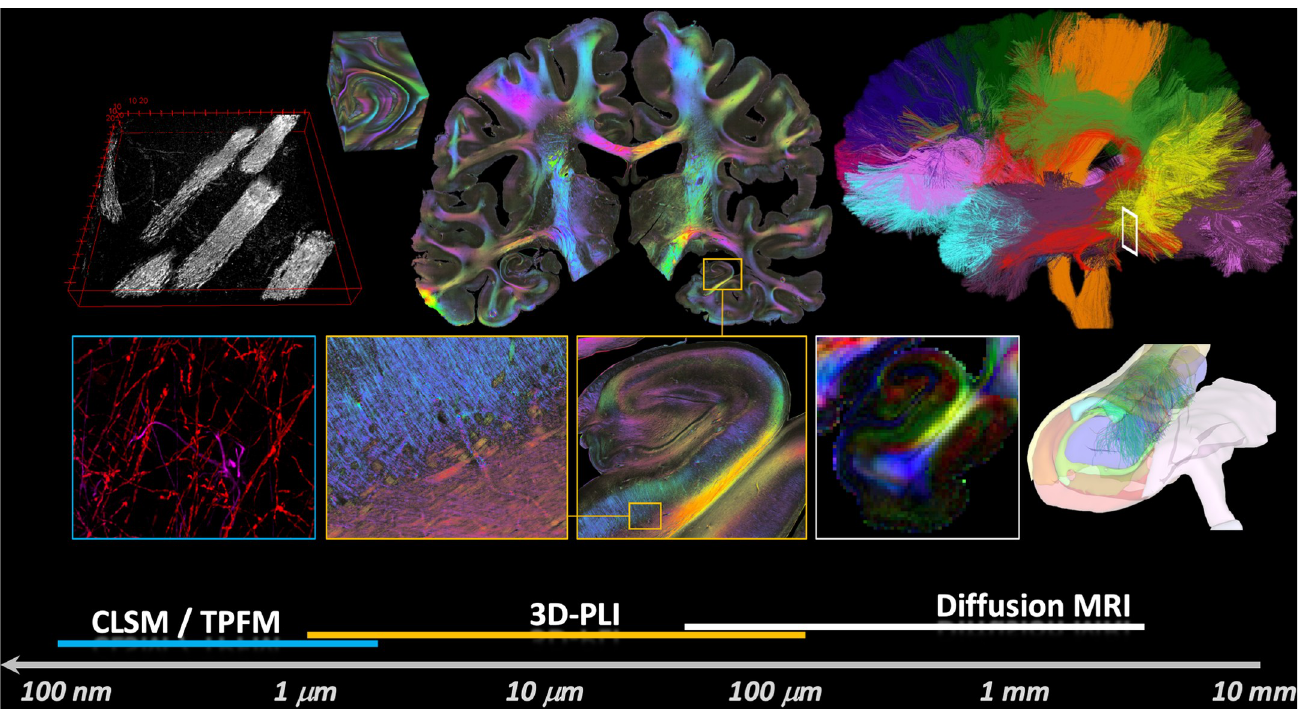
Fig 1. Multiscale organization of brain connectivity. Different methods are being used in the HBP to analyze neuronal connections from the nanometer scale to the centimeter scale. Although TEM/SEM (e.g., Rodriguez-Moreno and colleagues [5]) and CLSM/TPFM (e.g., Silvestri and colleagues [6]) can image subcellular structures, including synapse, with great detail, they cannot cover the whole human brain. 3D-PLI has a spatial resolution down to 1.3 μ m, which resolves most of the myelinated fibers, and has the potential to image the whole human brain (e.g., Axer and colleagues [7]). Diffusion MRI is an in vivo method covering the whole brain, but with limited spatial resolution, which does not resolve single nerve fibers (e.g., Beaujoin and colleagues [8]). The possibility to link these different data shows the great advantage of HBP—it facilitates the combination of approaches at scale, backed by high-performance computing and the data exchange infrastructure FENIX. CLSM, confocal laser scanning microscopy; FENIX, Federated Exascale Network for data Integration and eXchange; HBP, Human Brain Project; PLI, polarized light imaging; TEM, transmission electron microscopy; TPFM, two-photon fluorescence microscopy. Figure elements provided by Markus Axer